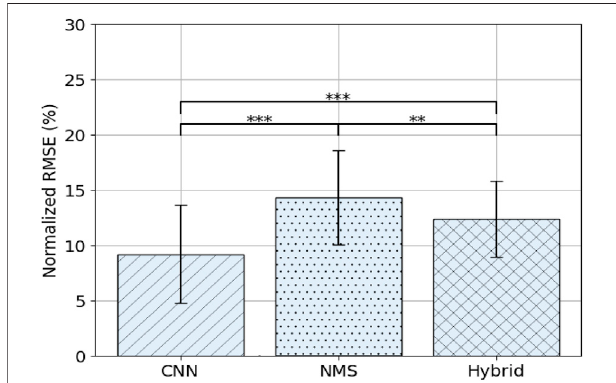
Frontiers in Robotics and AI |